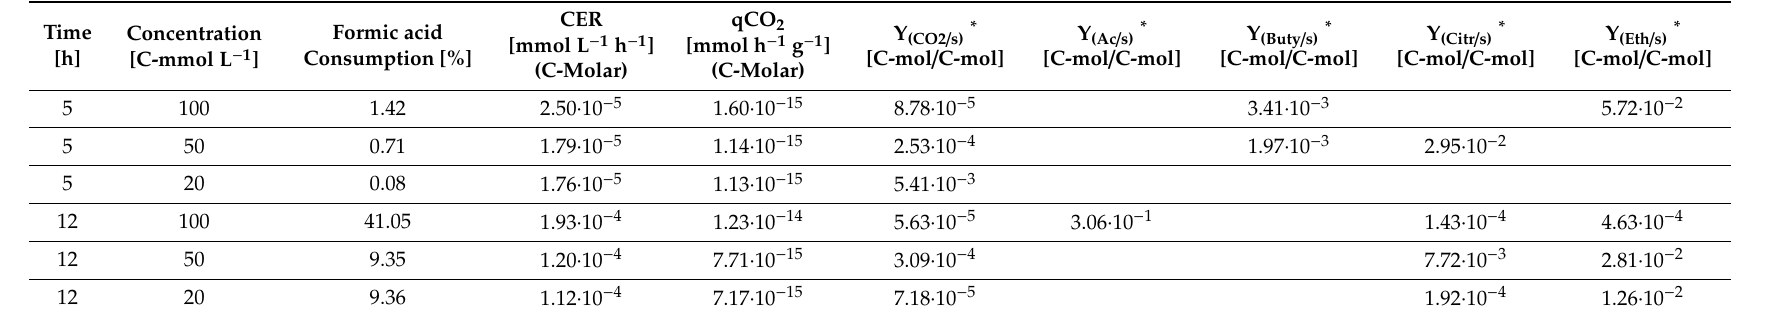
Table 4. Physiological key variables of D. amylolyticus obtained from whole cell conversion experiments on formic